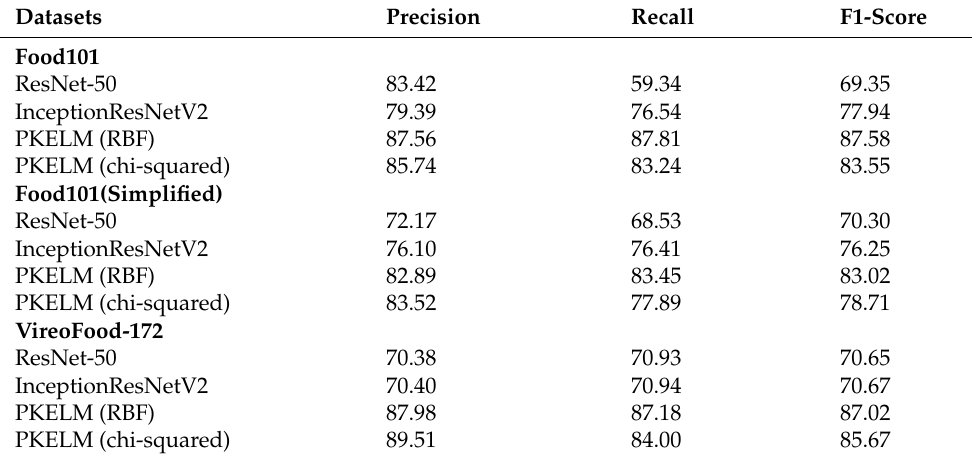
Table 6. Comparison of final measures of food ingredient recognition for Food101 and VireoFood- 172